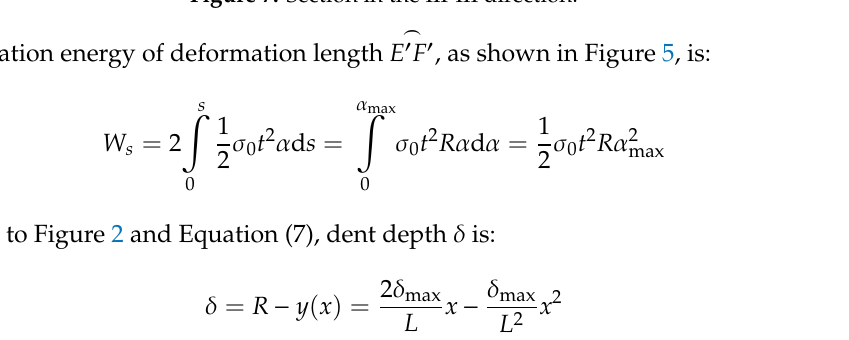
Figure 7. Section in the Ⅲ - Ⅲ direction.